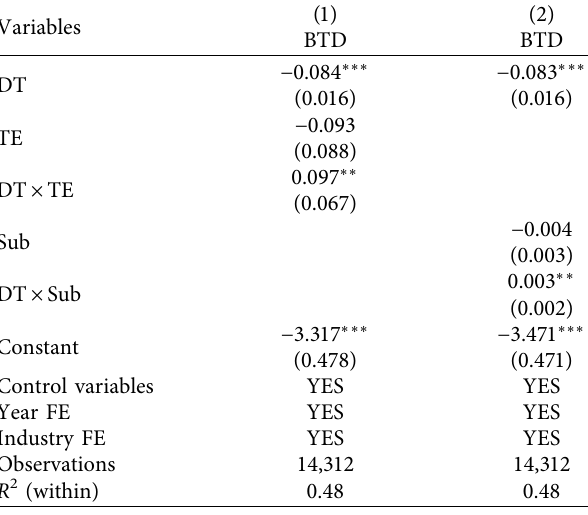
Table 6: Regression results for moderating efects.